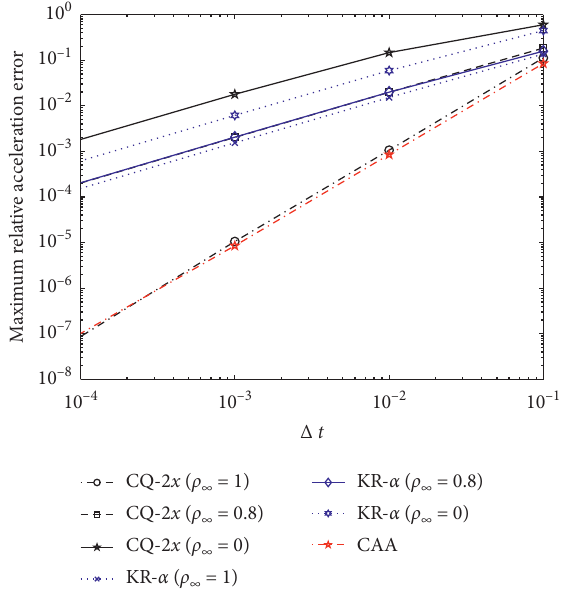
Figure 11: Convergence rate of CQ-2 x assessed in terms of the maximum relative acceleration error.